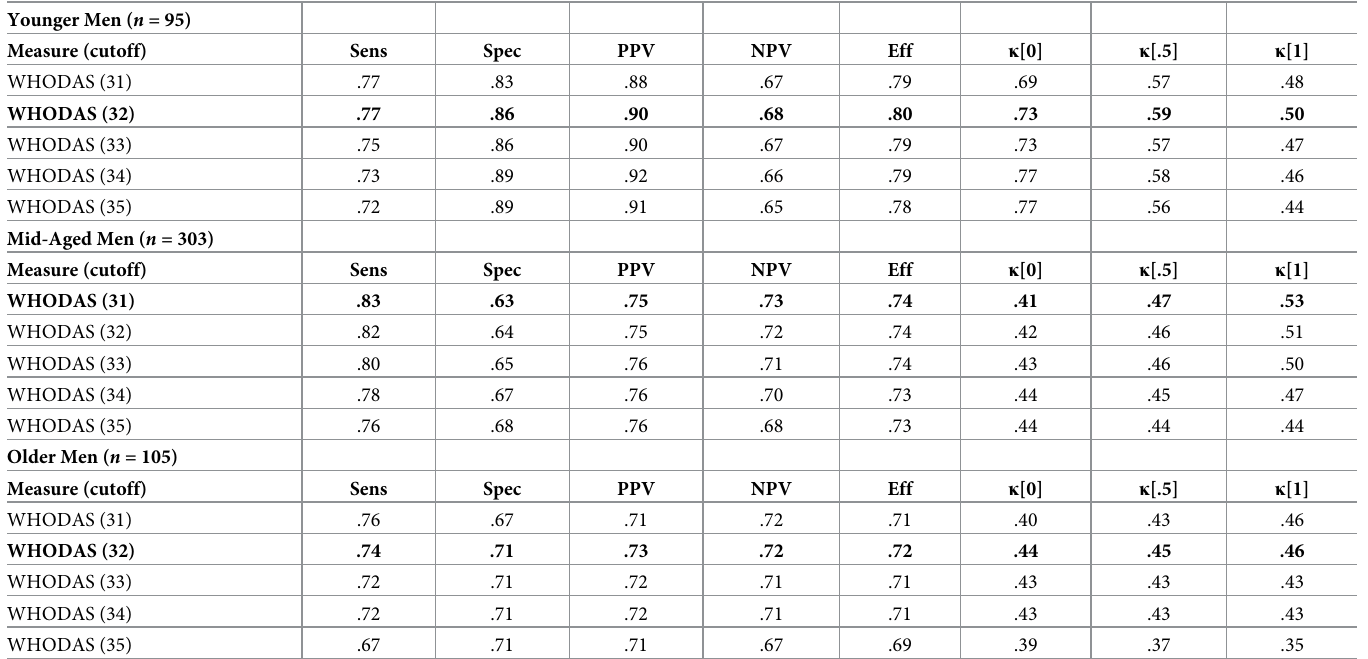
Table 4. Diagnostic utility of WHODAS total score for predicting functional impairment on the CAPS (either IV or 5) among younger, mid-aged, and older men. Younger Men ( n = 95) Measure (cutoff) Sens Spec PPV NPV Eff κ [.5] WHODAS (31) .77 WHODAS (32) .77 WHODAS (33) WHODAS (34)